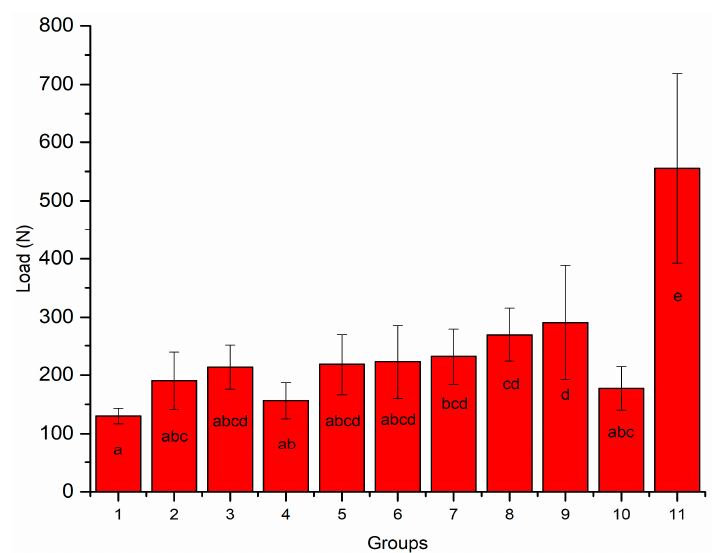
Figure 3. Mean values of load-bearing capacity (N) with standard deviation of tested restorations (Groups 1–10) and intact teeth (Group 11). Groups denoted with the same letters are not statistically different ( p < 0.05).